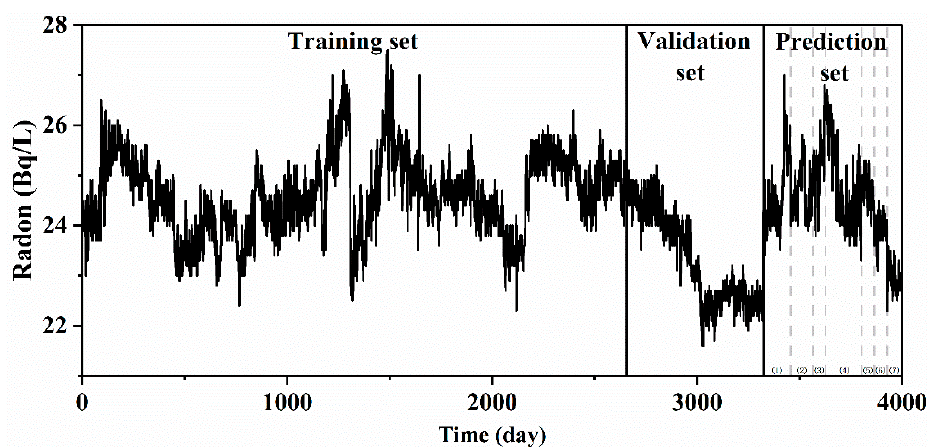
Figure 4. The collated data of the groundwater radon, including training set, validation set, and prediction set. Prediction sets (1)–(7) represented the 7 seismic activity periods.